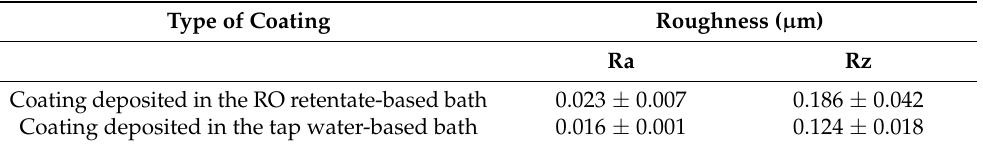
Table 6. Results of measurements of roughness parameters Ra and Rz of zinc coatings obtained from two types of baths.